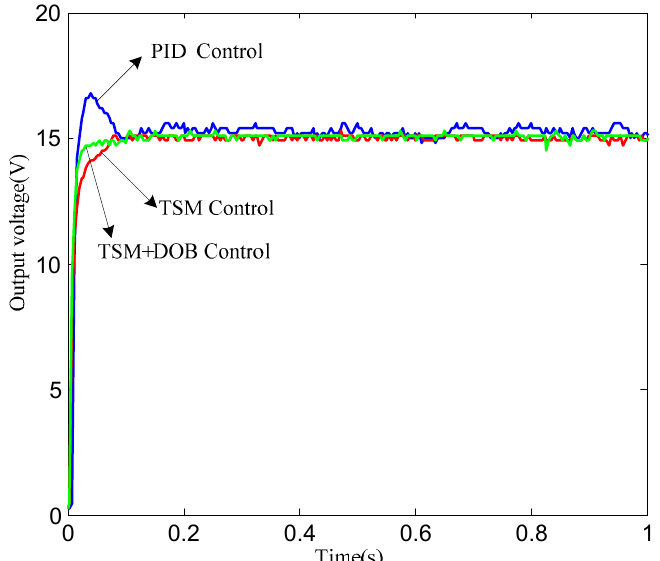
Figure 13. Experimental start ‐ up waveforms of the output voltage and inductive current under the TSM + disturbance observer (DOB) controller.